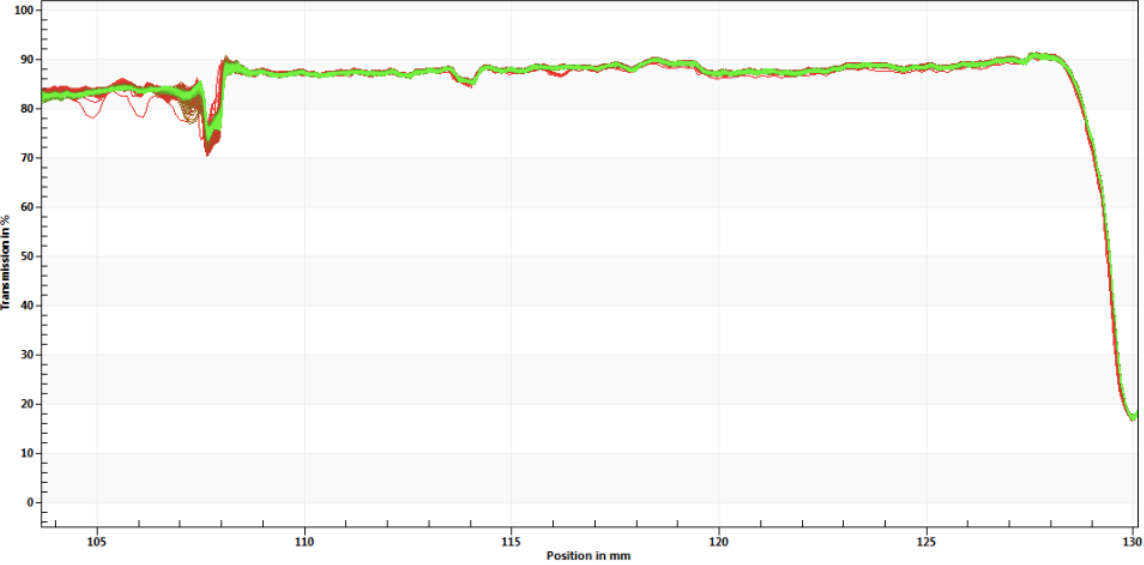
Figure 5. Instability profile of nanoemulsion 4 on the day of production (day 0).